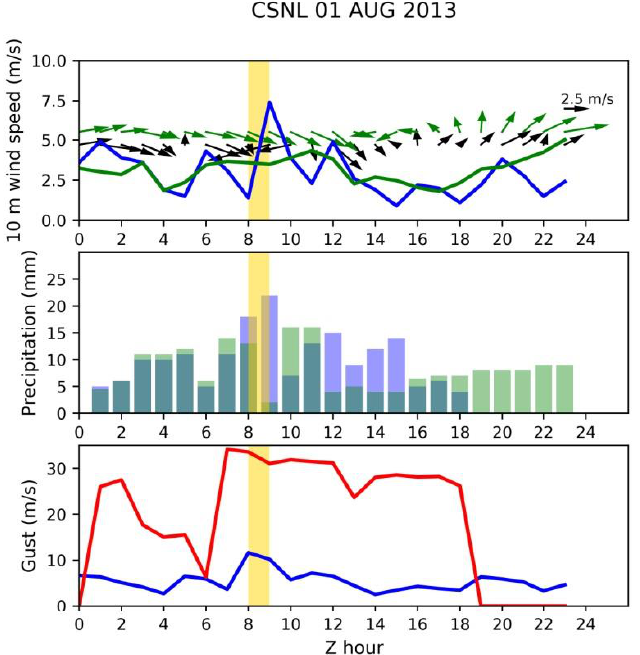
Figure 6. Meteogram at CSNL station for a storm at 09:00 Z 01 August 2013. Wind-ramp timing is shaded in yellow. CMORPH [43] maximum precipitation in the center of the storm is in blue bars. Estimated wind gust in the storm is in red line and observed wind gust at CSNL is in blue. Forecasted wind speed, wind vector and precipitation are in green.